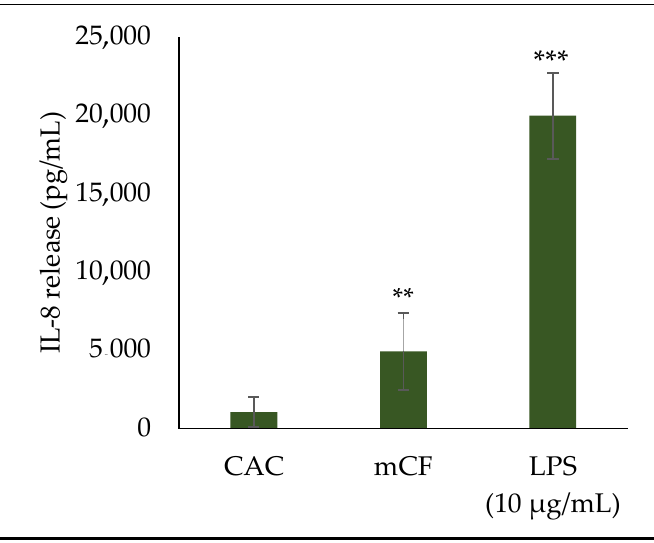
Figure 7. Interleukin-8 (IL-8) release from BEAS-2B/dTHP-1/CCD-33Lu triple-cultures after expo- sure to mechanically treated carbon fibers (mCF) and 10 µg/mL lipopolysaccharide (LPS). CCD-33Lu cells were seeded on inverted inserts with a density of 9 × 10 4 /cm 2 . After 1 h, the inserts were inverted, and BEAS-2B cells were seeded with a density of 2 × 10 5 /cm 2 . After 4 h, dTHP-1 cells (3.9 × 10 4 /cm 2 ) were seeded on top of the BEAS-2B cells. On the next day, mono- and co-culture were exposed to CF samples with average surface doses of 7.00 ± 1.25 µg/cm 2 mCF for 1 h and post- incubated for 23 h. Clean air controls (CAC) and LPS-exposed cultures received equivalent treat- ment. The supernatants were analyzed for IL-8 release. The mean values ± SD of at least three inde- pendent experiments performed in duplicates are displayed. Statistical analysis was performed to assess differences between untreated and treated cells using Student’s t -test: ** ( p ≤ 0.01), *** ( p ≤ 0.001).